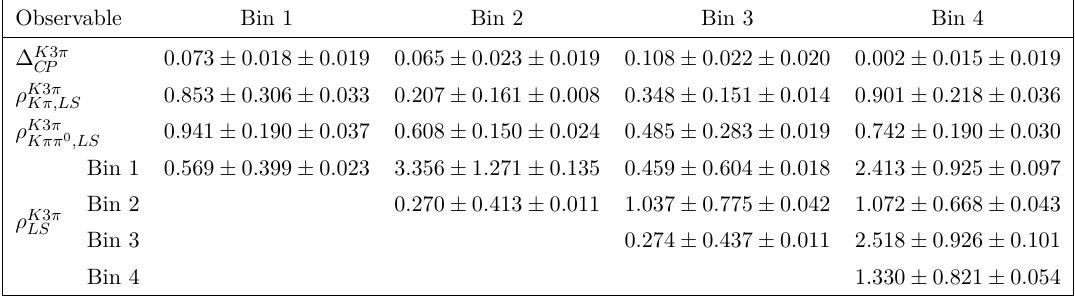
Table 13 . The measured binned observables for D → K − π + π + π − . The first uncertainty is statistical and the second